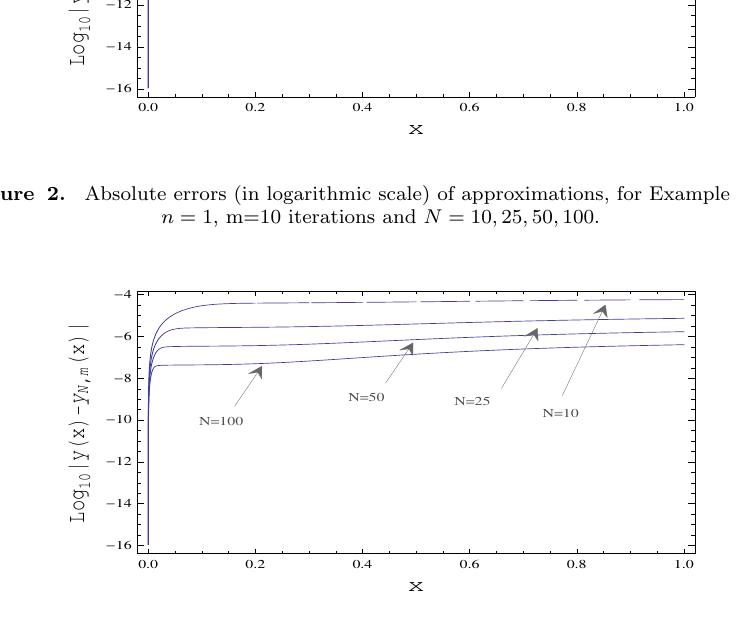
Figure 3. Absolute errors (in logarithmic scale) of approximations, for Example 1 with n = 5, m=10 iterations and N = 10 , 25 , 50 , 100.